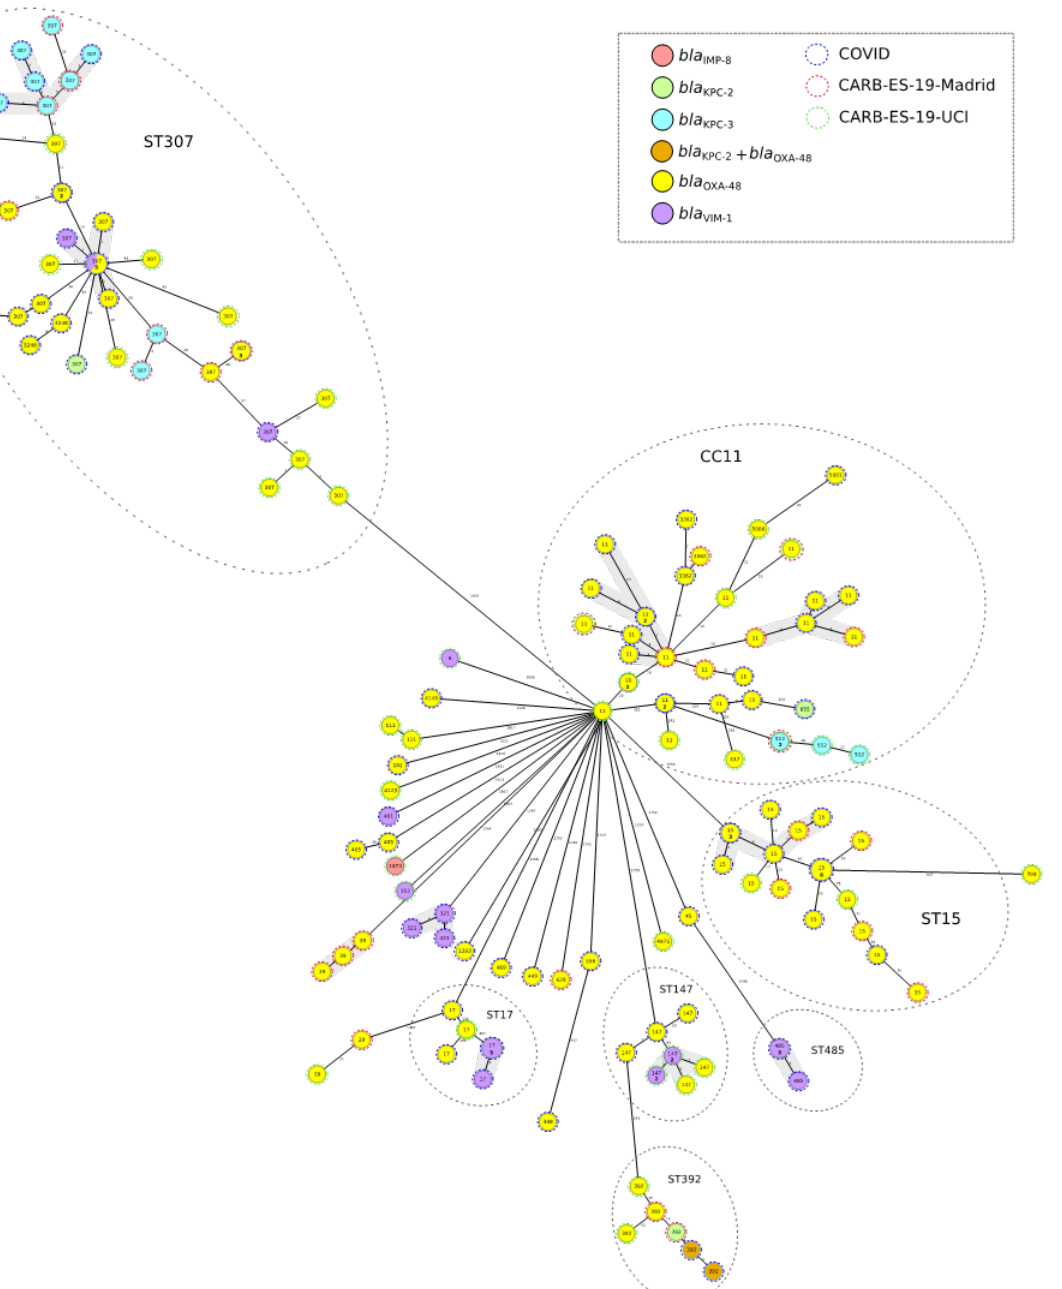
Figure 2. Population structure of carbapenemase-producing Klebsiella pneumoniae isolated from COVID patients compared to pre-pandemic isolates: Distances shown in minimum-spanning tree are based on cgMLST of 2358 genes using the parameter ‘pairwise ignoring missing values’. Colors in each circle indicate carbapenemase type, and numbers indicate the sequence type (ST). Dotted circles in blue, red, and green represent the three study groups (COVID-19, Madrid-CARB-ES-19, ICU-CARB-ES-19). Grey ovals represent clusters. For circles that correspond to more than one isolate, the number of isolates is indicated in bold font. Gray shadows represent groups of strains; a threshold of 10 alleles was